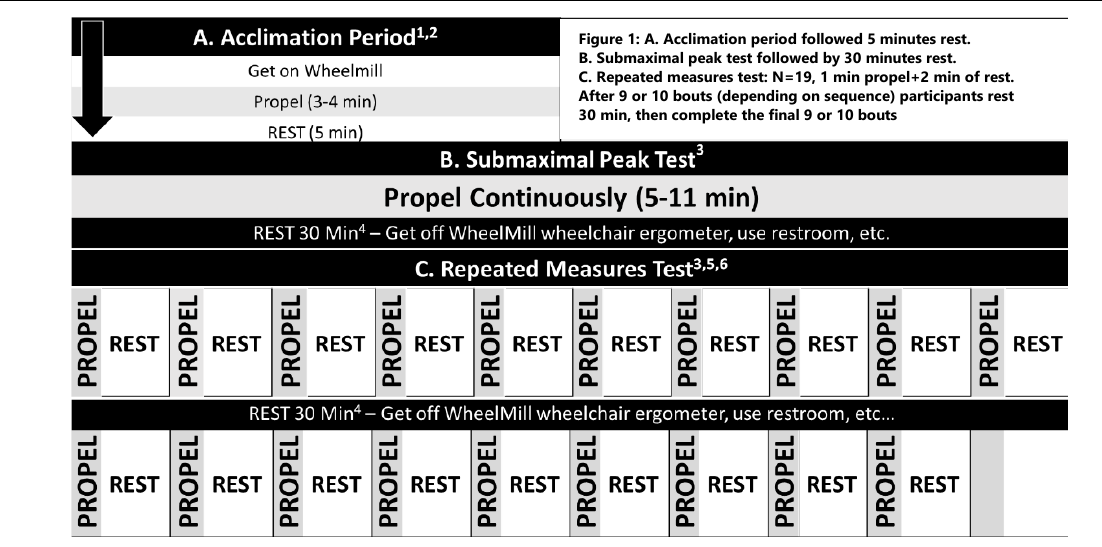
Figure 1 . Summary of Testing Protocol.